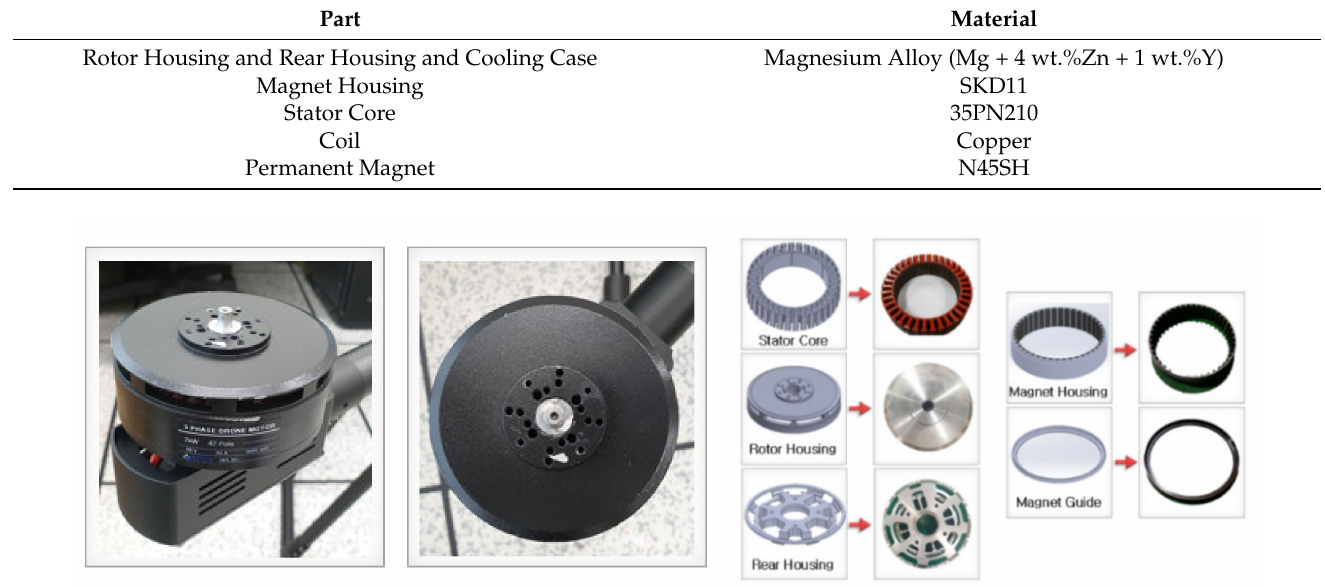
Table 3. Material of the prototype parts.